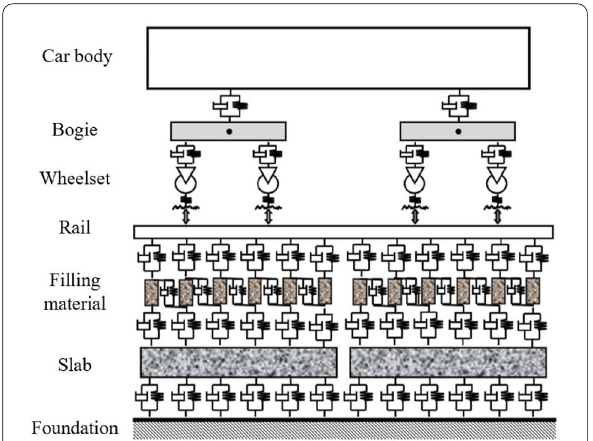
Figure 1 Schematic of embedded track dynamic